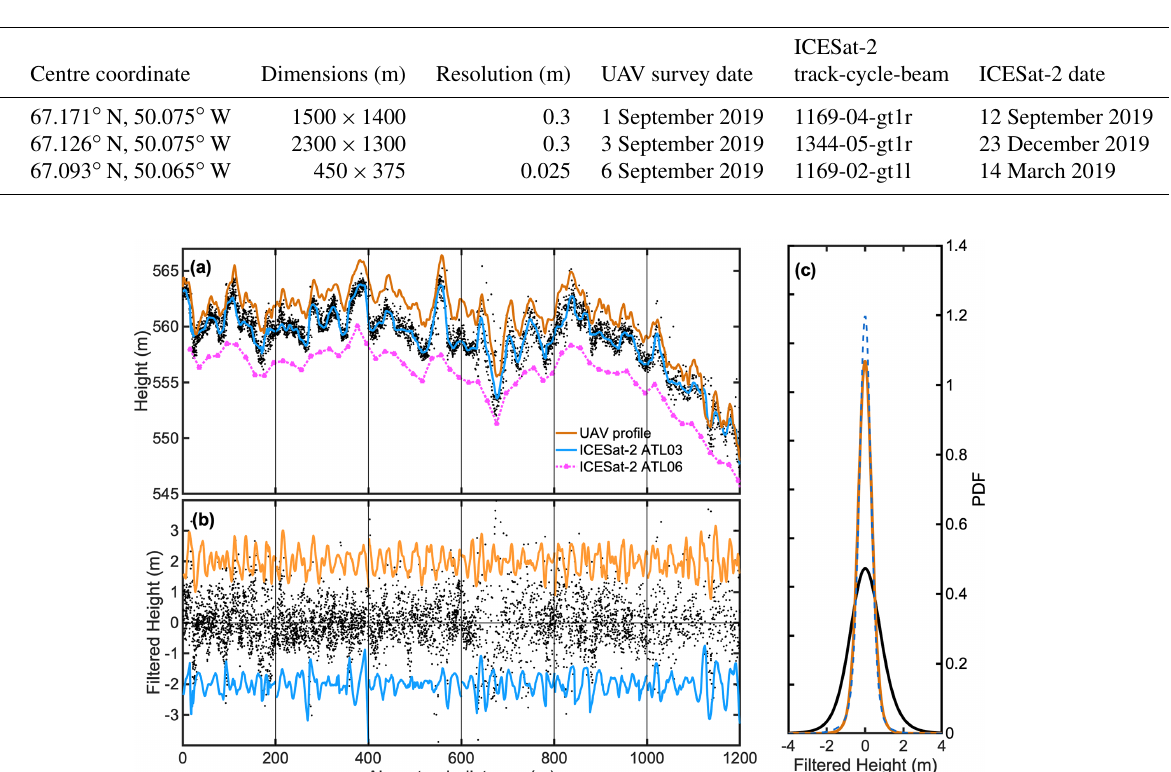
Figure 4. (a) Elevation profile at site A measured by the UAV and by ICESat-2 (solid lines), selected ICESat-2 photons (black dots), and ICESat-2 ATL06 height (pink dashed line). The UAV and ATL06 profiles have been vertically offset by 2m for clarity. (b) Filtered profiles (solid lines) and residual photon elevations after filtering per 200m windows (grey dots), where the UAV and ATL03 filtered profiles have also been vertically offset. (c) Probability density function of the filtered ICESat-2 profile (blue dashed line), UAV profile (orange solid line), and residual photon elevations (black